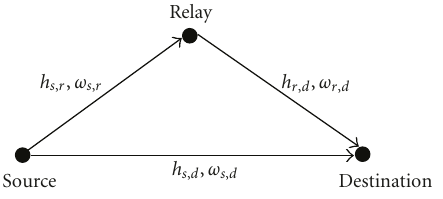
Figure 1: Cooperative communication system with carrier o ff sets.